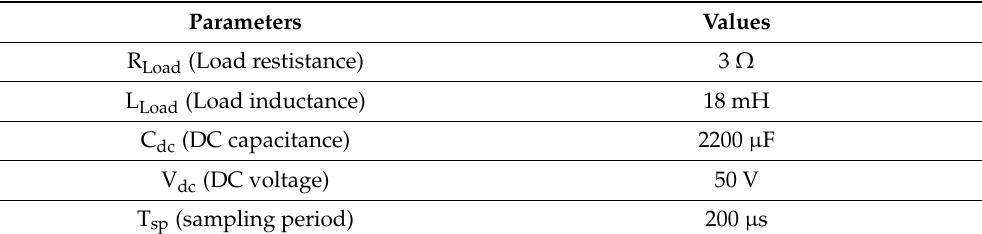
Figure 7. Prototype photo of a three-level three-phase four-leg inverter for application of the model predictive control technique. Table 6. Parameter for the inverter